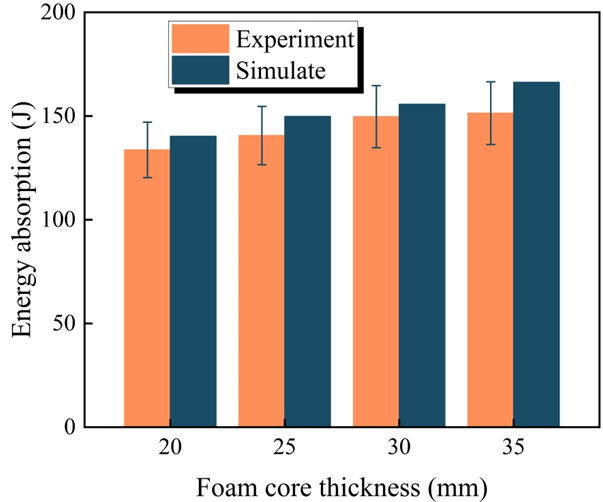
Figure 5. Comparison of CSP’s simulated and experimental impact energy absorption with different foam core thicknesses [25].